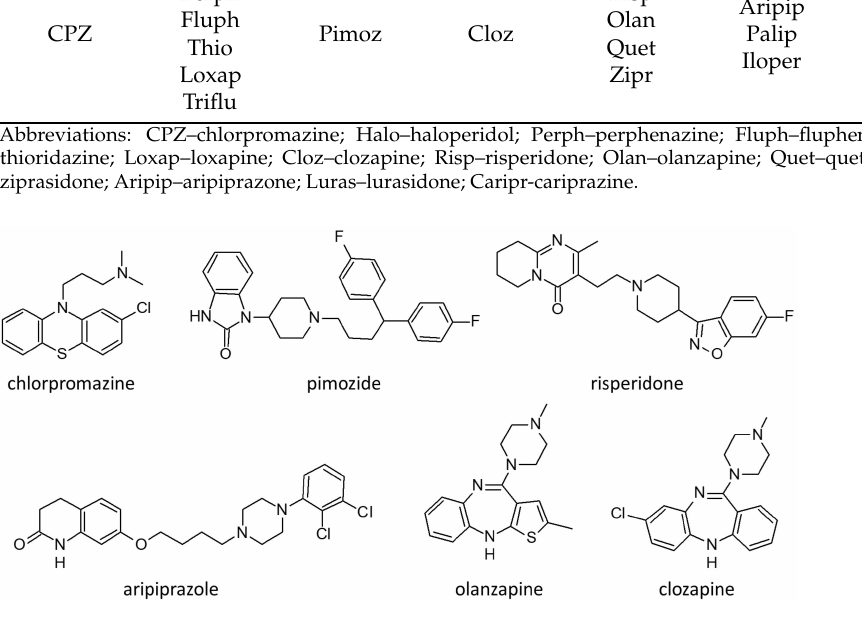
Figure 2. Molecular structure of the main antipsychotics used to treat patients with delusional